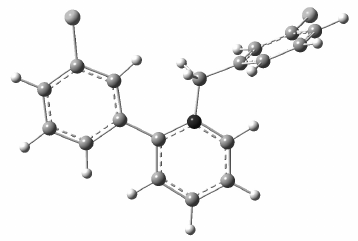
Figure 1 . The transition state